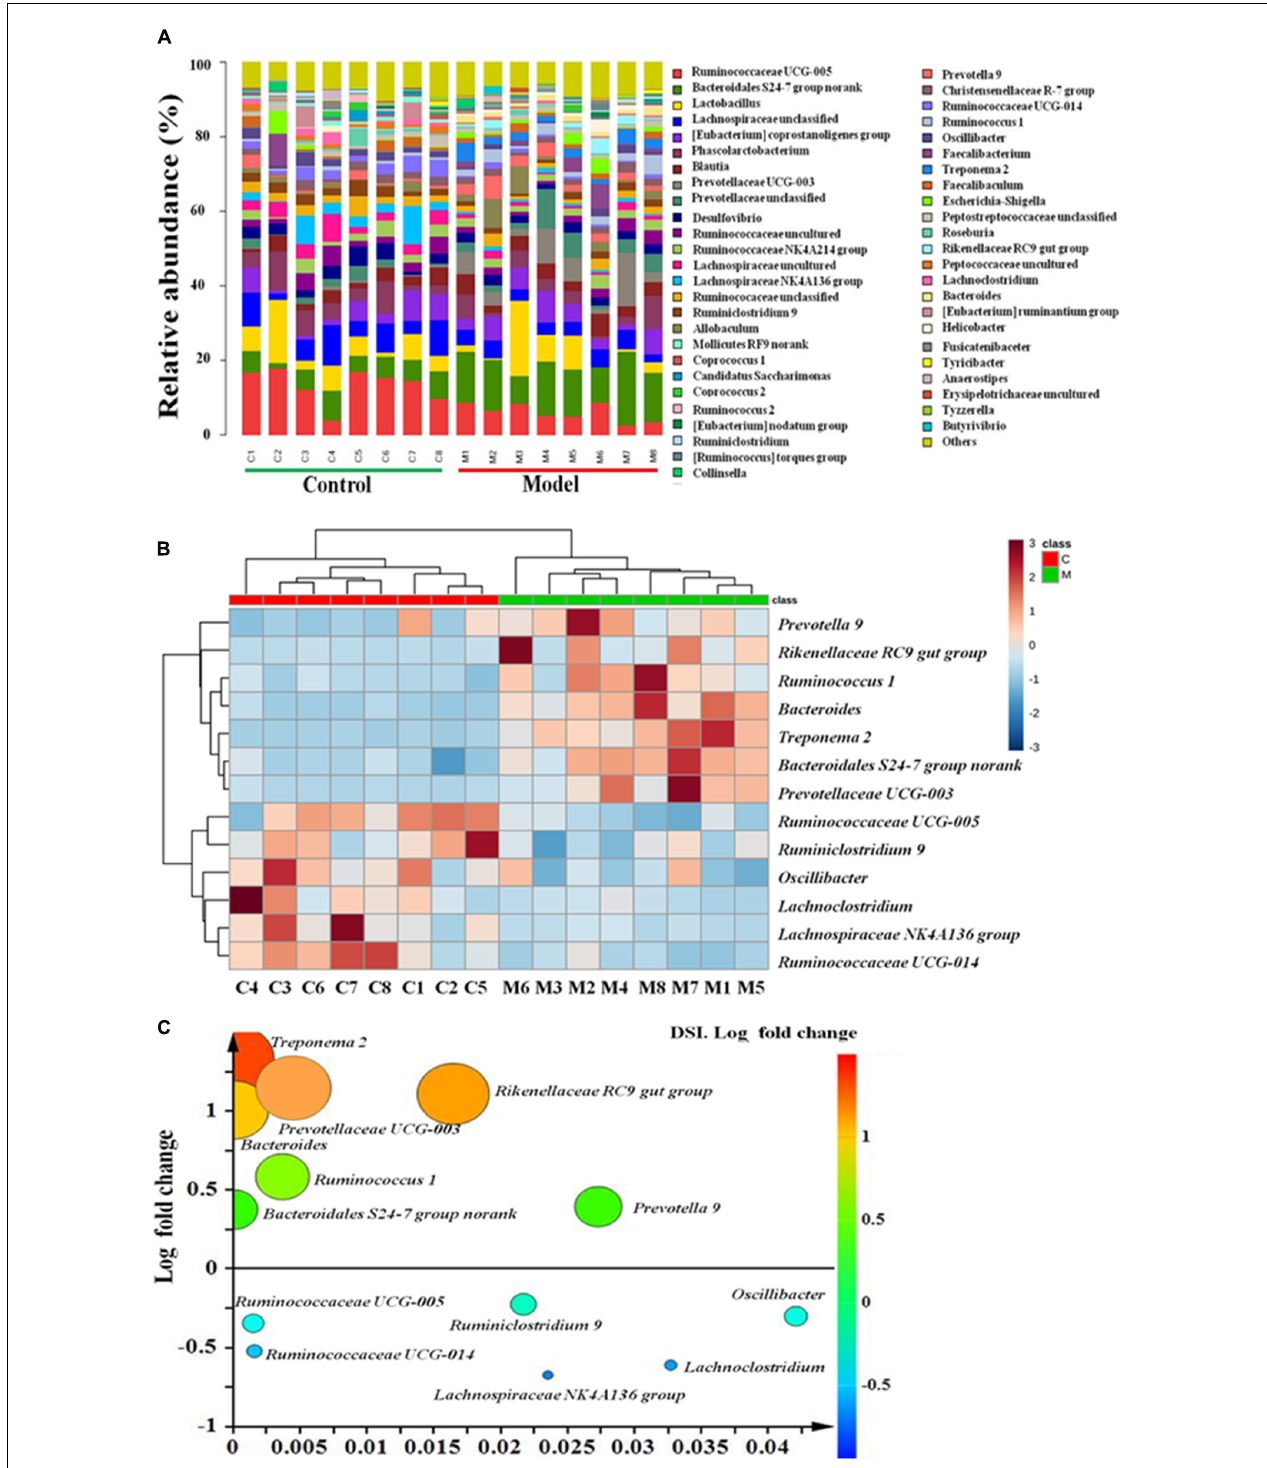
FIGURE 3 | The gut microbiota at genus level in ISO-induced AMI occurs strikingly changes. (A) Relative abundance of gut microbiota at genus level in model and control groups. (B) The heat map summarizing the thirteen altered genera in ISO-induced AMI and control groups. Red, high concentrations; white, medium concentrations; blue, low concentrations. (C) Fold changes and p -values of significant altered genera in cecal contents in ISO-induced AMI compared with control group.